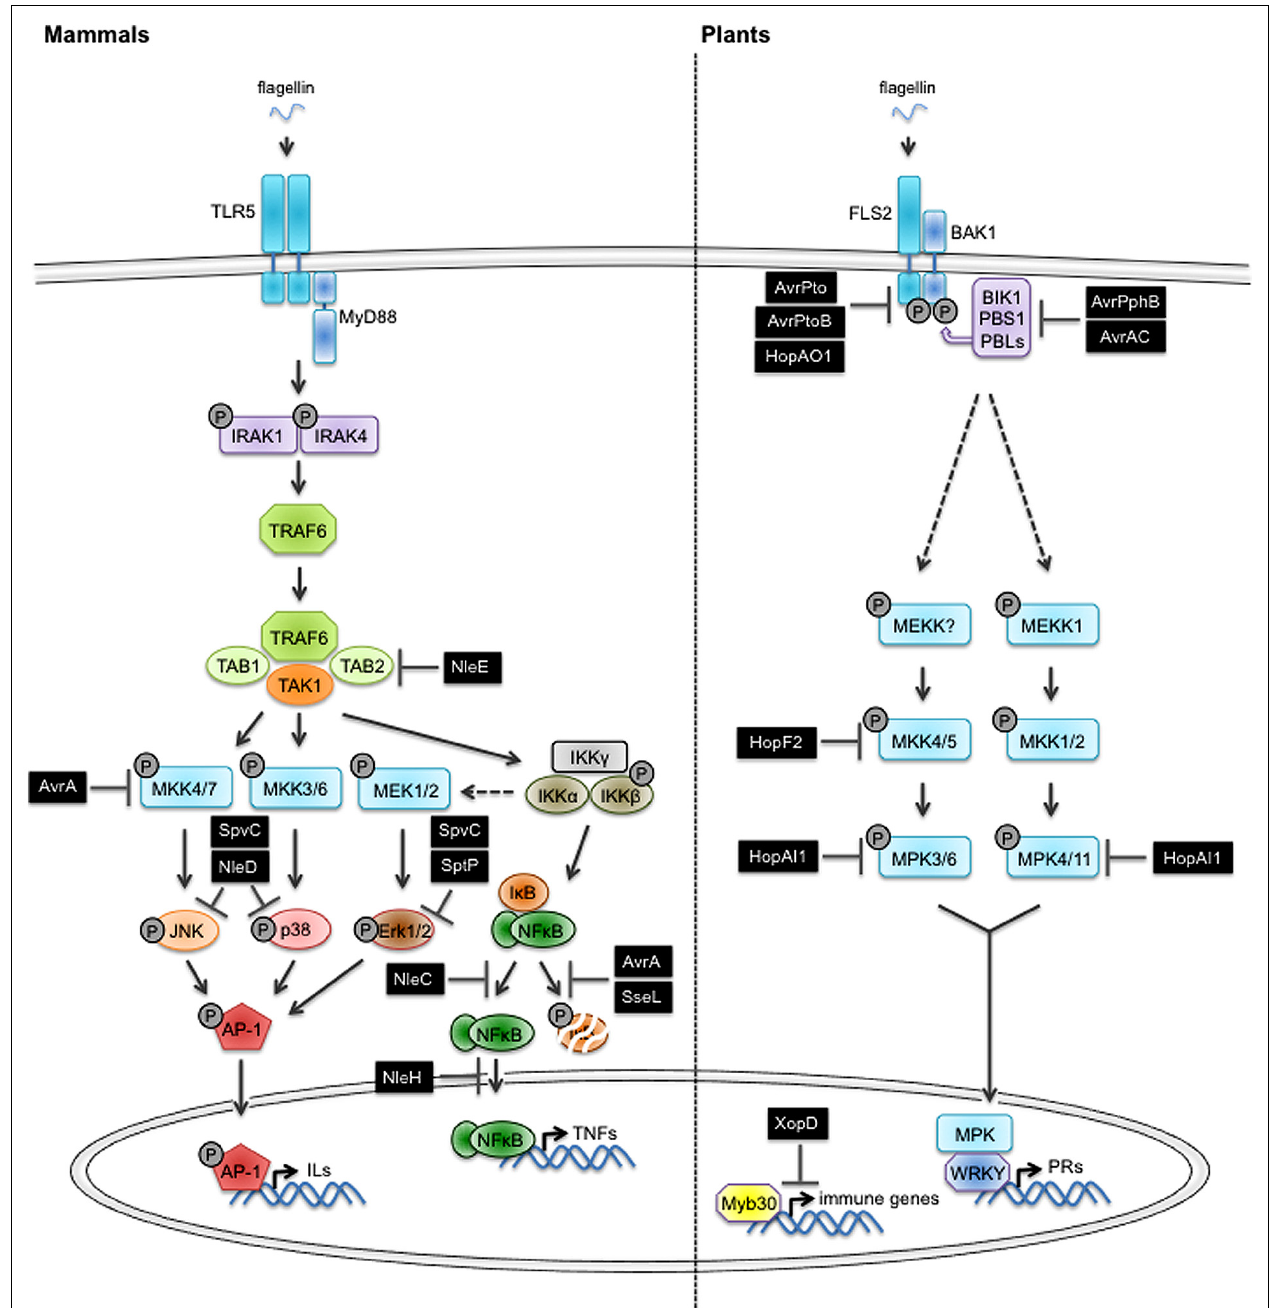
FIGURE 1 | Overview of the PTI/MTI-suppressing function of type three effectors from enterobacteria and phytopathogenic bacteria. The perception of pathogen/microbe-associated molecular patterns (PAMPs/MAMPs) by pattern recognition receptors (PRRs) triggers signaling pathways conferring immunity (PTI/MTI) that are conserved in mammals and plants. Host-adapted bacterial pathogens use the type three secretion system (T3SS) to inject effectors (T3E) that compromise PTI/MTI. Components of basic plant defense and interfering pathogen effectors (black box) are depicted. See main text for additional details. Abbreviations used in the figure: TLR5, Toll-like receptor 5; FLS2, Flagellin Sensitive 2; MyD88, Myeloid Differentiation primary response gene